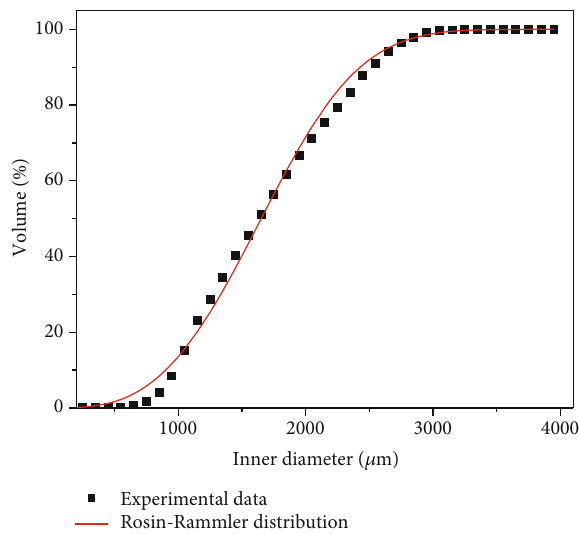
Figure 10: Histogram of particle shape distribution of the form factor and ellipse